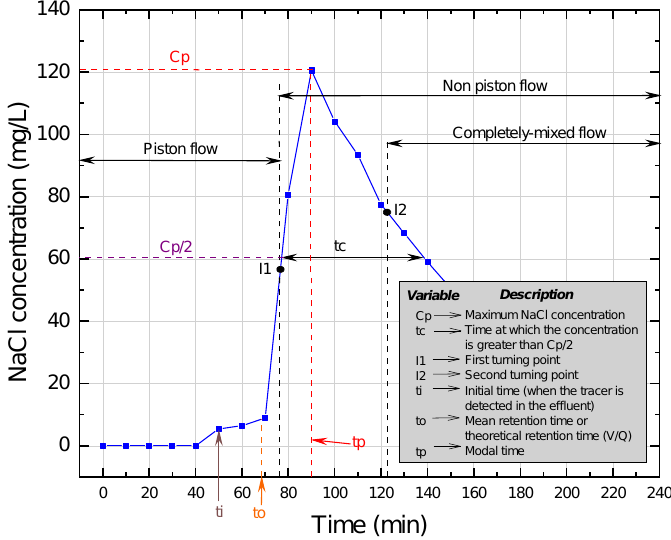
Figure 2. Variation of tracer concentration in the effluent of the UGFL–Flow 1.0 m 3